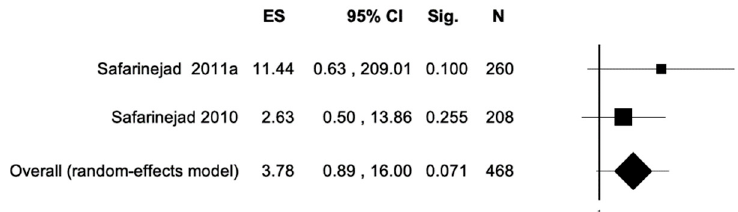
Figure 5. Forest plot showing the OR for diarrhea. ES, effect size; CI, confidence interval. (I2 = 0.00, p = 0.389).